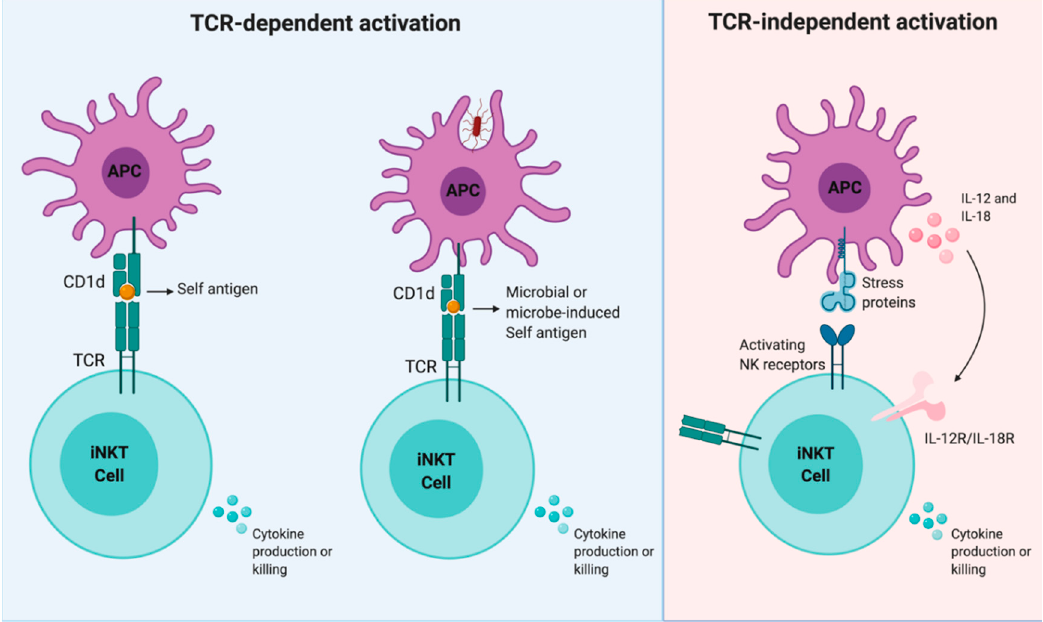
Figure 1. Mechanisms of iNKT cell activation.